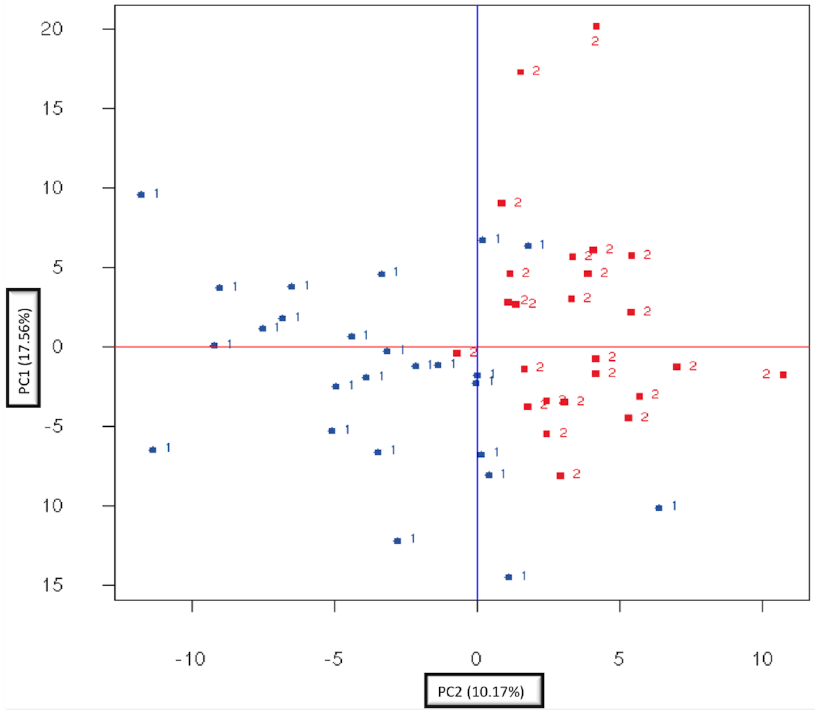
Figure 2. Principal component analysis (PCA). PCA plot showing separation of the sun-exposed and sun-protected skin samples. 1- unexposed inner arm. 2- exposed outer arm.